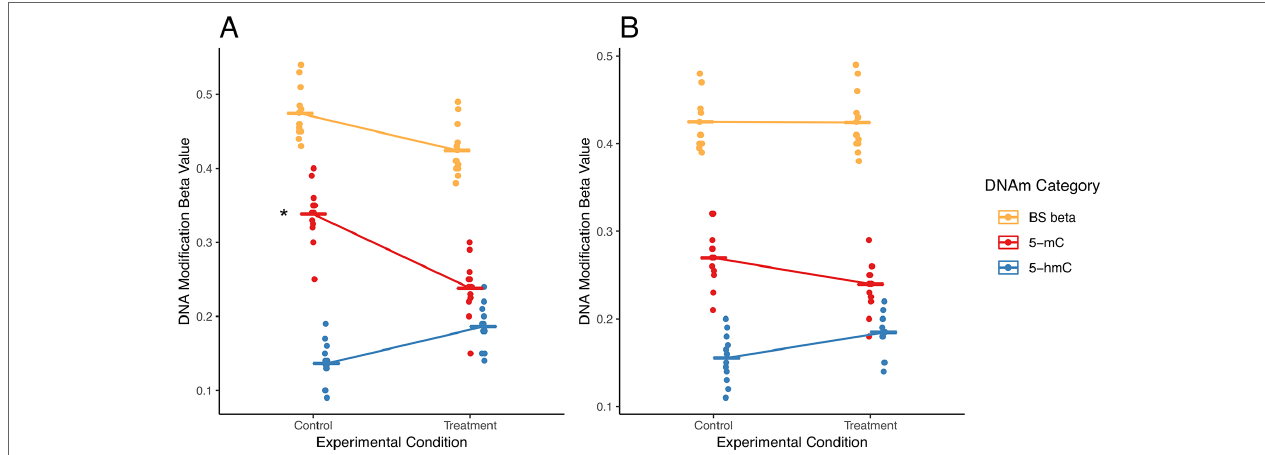
FIGURE 3 | Examples of simultaneous, treatment-related changes in 5-mC and 5-hmC. Here, we use mock data to present two hypothetical scenarios in which experimental condition alters levels of 5-mC and/or 5-hmC in brain tissue. (A) In the first example, 5-mC significantly decreases, and 5-hmC shows a nonsignificant increase at a CpG site, while combined levels of DNA modifications decrease in exposed compared with those in control. Using a “traditional” modeling approach with separate models for each DNA modification, only the significant change in 5-mC would be identified (as indicated by asterisk), whereas the corresponding shift in 5-hmC at this CpG would not be identified. Our proposed interaction term model would identify this CpG as a site where there is a shift in the balance between 5-mC and 5-hmC. As such, our proposed analysis would supplement the information produced by the traditional model. (B) In the second example, 5-mC shows a nonsignificant decrease, and 5-hmC shows a nonsignificant increase at a CpG site; meanwhile, combined DNA modifications remain the same by experimental group. Using a “traditional” modeling approach with separate models for each DNA modification, this CpG would not be identified as significant for either epigenetic mark. However, depending on the statistical power of our test, our proposed interaction term model could identify this CpG as a site where there is a shift in the balance between 5-mC and 5-hmC. As a result, our proposed analysis would provide additional information about the subtle shifts in these epigenetic marks at this CpG site. The asterisk indicates a significant change by experimental condition that would be identified using separate models for each DNA